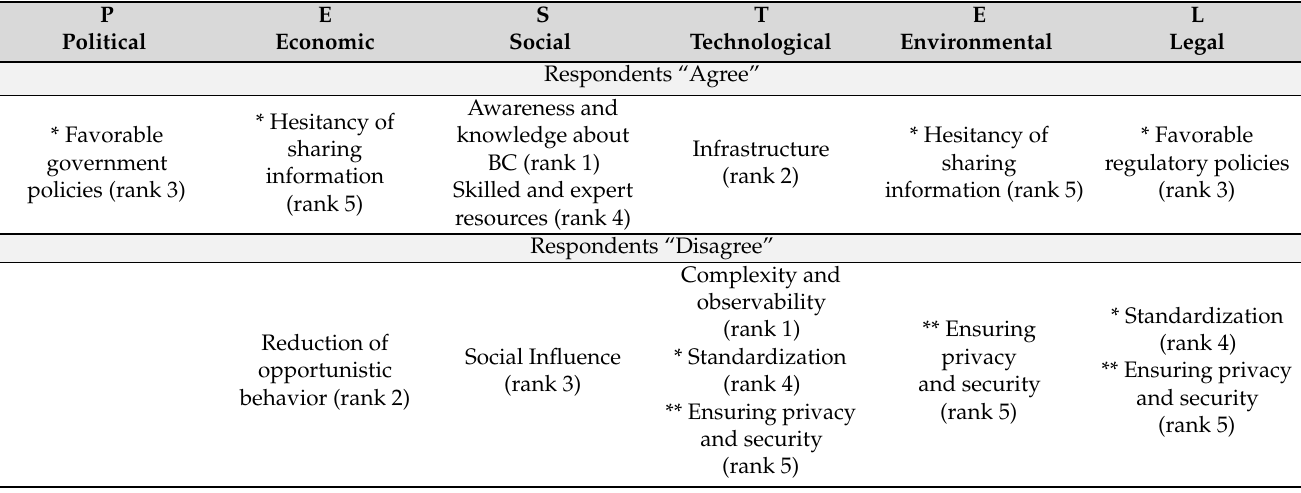
Table 2. PESTEL quantitative analysis of selected constructs that affect BC adoption in developing countries: Montenegro and South Africa (Source: